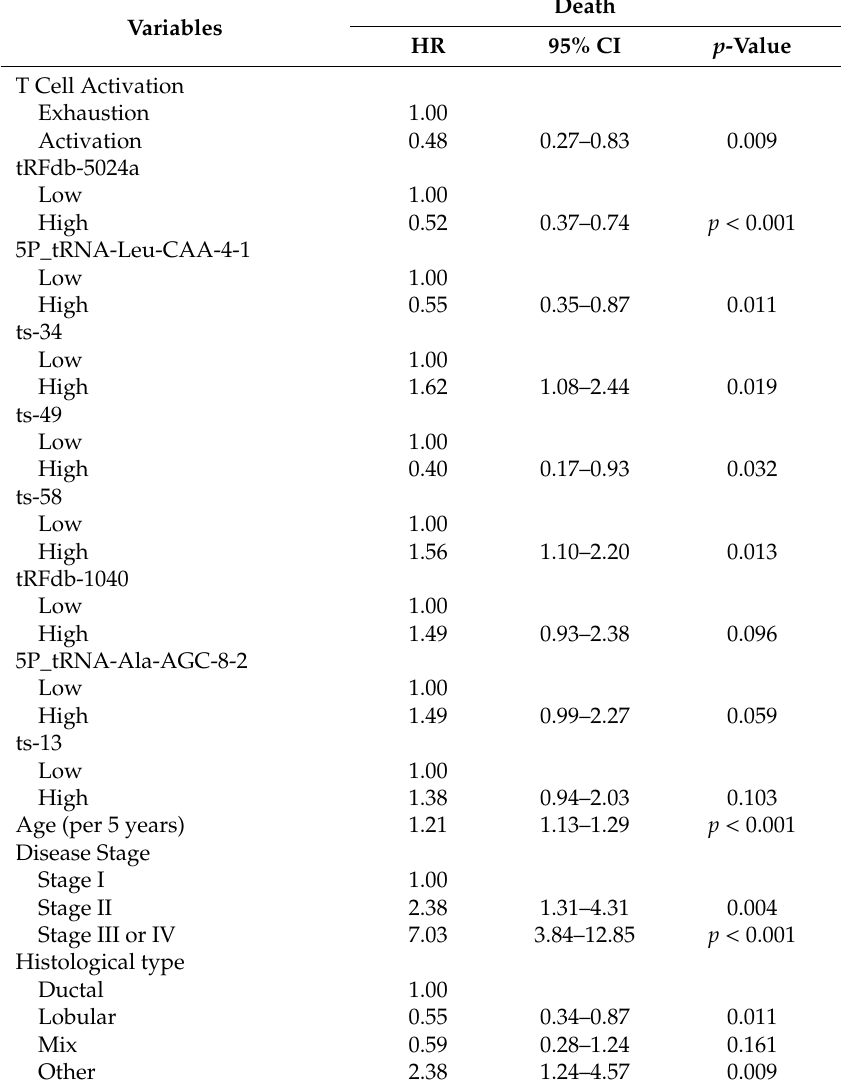
Table 1. Relationships between overall survival and tRNA-derived fragments (tRFs).